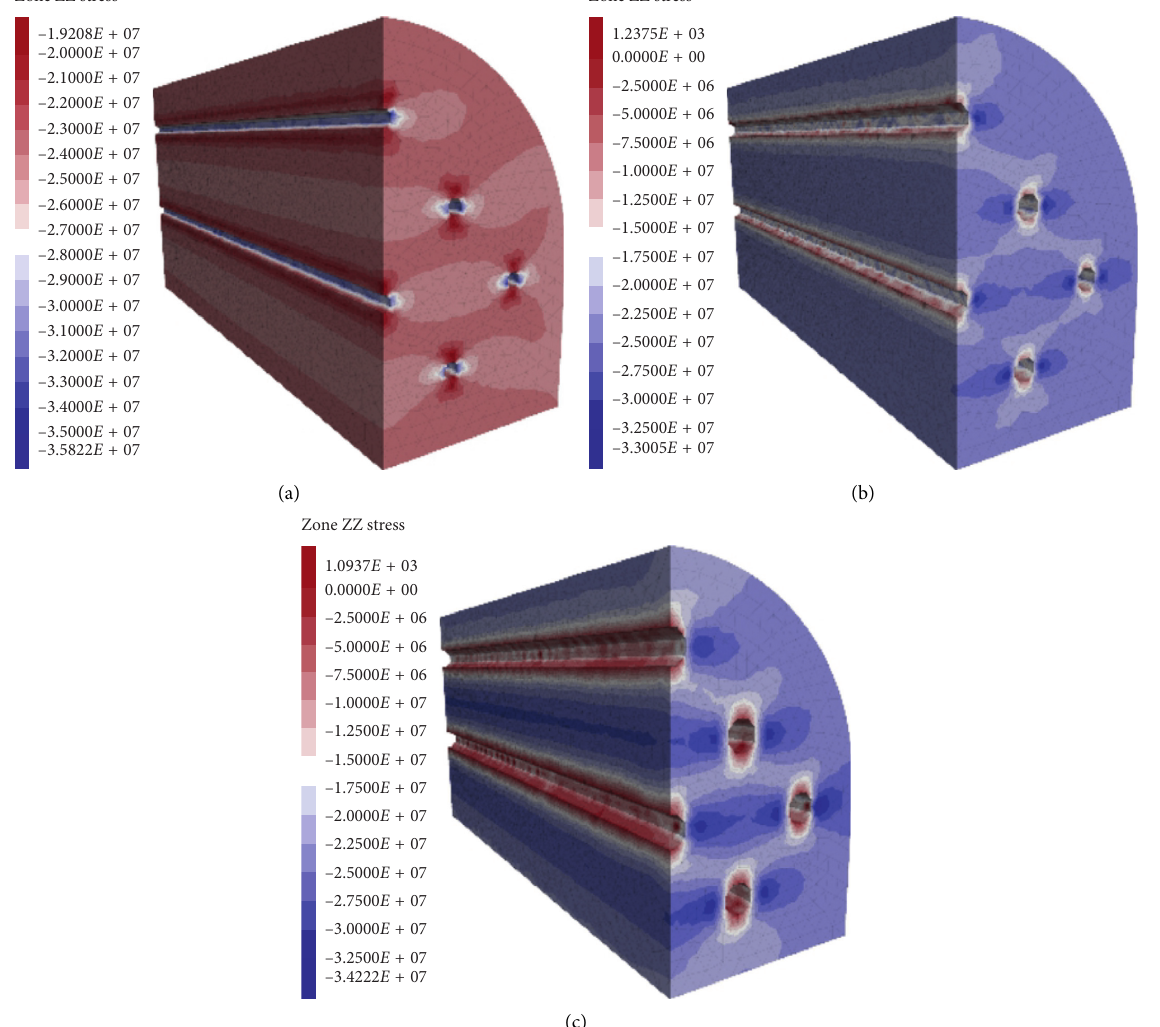
Figure 7: Vertical stresses of pressure relief boreholes. (a) Φ 100mm. (b) Φ 200mm. (c) Φ